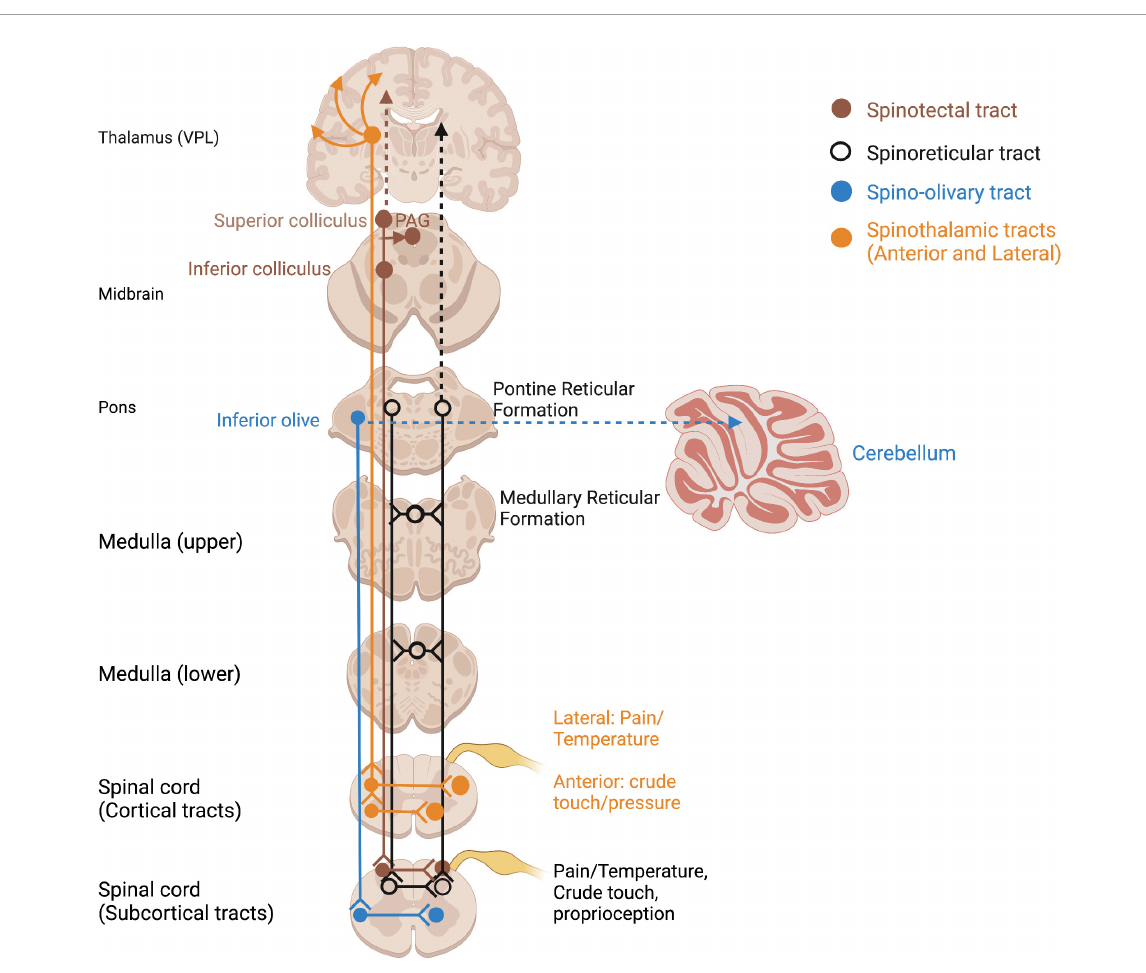
FIGURE3 Ascending spinothalamic and subcortical somatosensory tracts. Open circles reflect terminations of sensory tracts, after which projections take various pathways. PAG, periaqueductal gray; VPL, ventral posterior lateral nucleus of